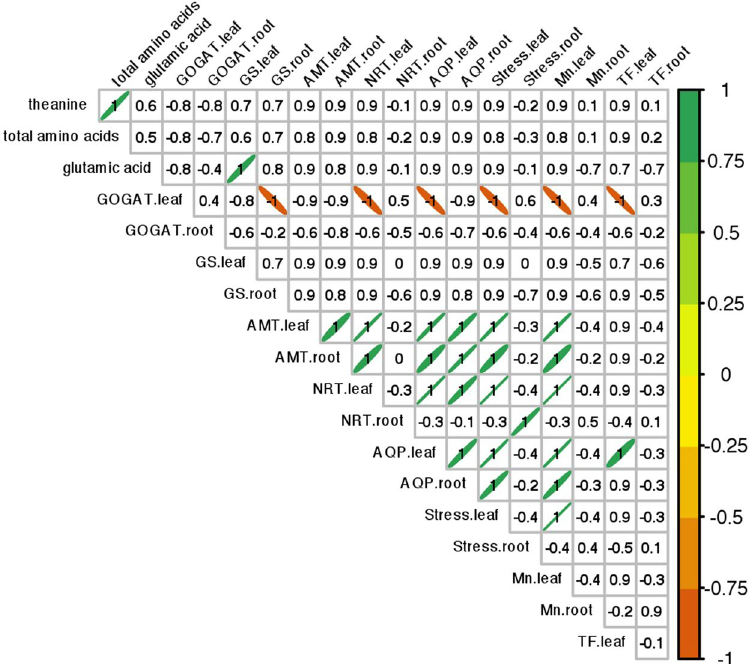
Figure 5. Correlations between amino acid content and gene expression in the Camellia leaves. This diagram shows the correlations between amino acid contents in leaves and gene expression levels. The gene name followed by “.leaf” or “.root” included i) four shared DEGs associated with stress, manganese (Mn), transcript factors (TF) and AQP in both the roots and leaves of two Camellia varieties, ii) differentially expressed N uptake genes AMT and NRT , and iii) Glu metabolism pathway genes GS and GOGAT . The number in each cell represents the coefficient. The significant (P < 0 . 05 ) correlations were marked with an ellipse, and the direction denotes a positive or negative